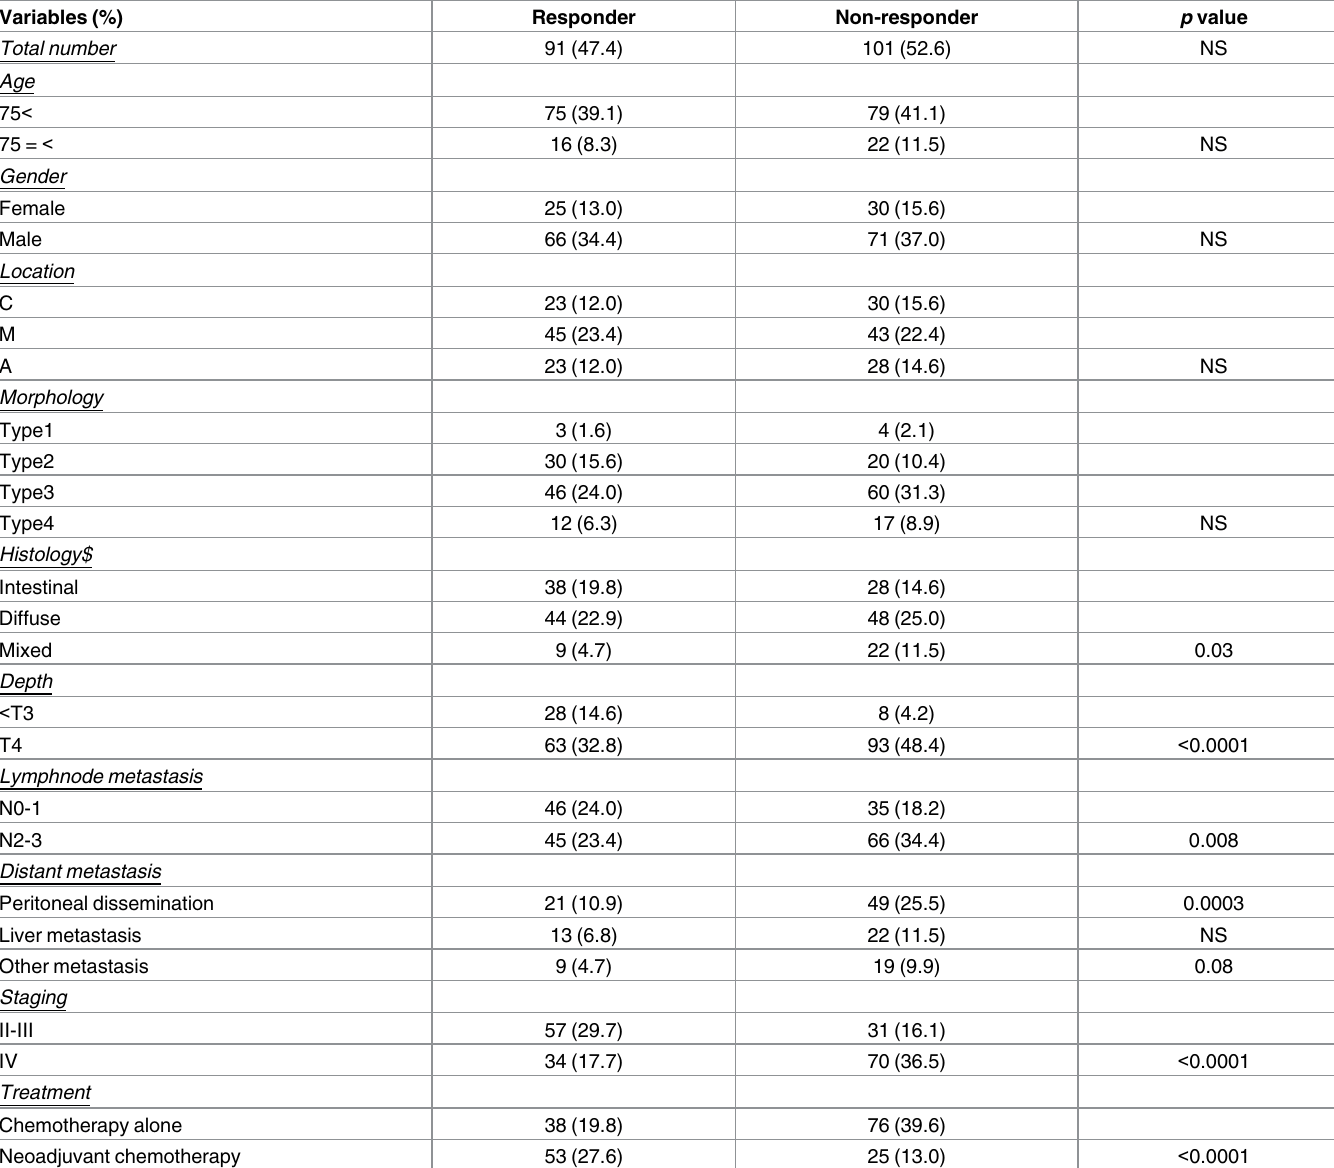
Table 4. Association between clinicopatological characteristics of gastric cancer and response to chemotherapy based on